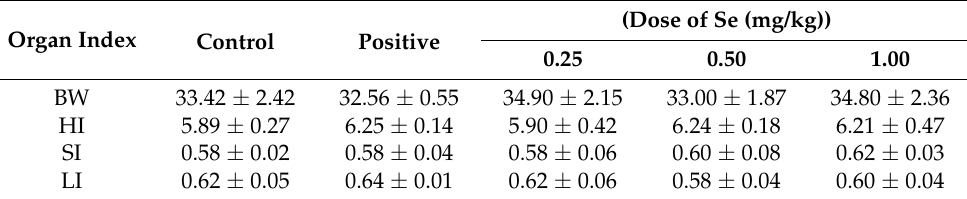
Table 1. The effect of Glycine nano-selenium on weight gain and organ index. Organ